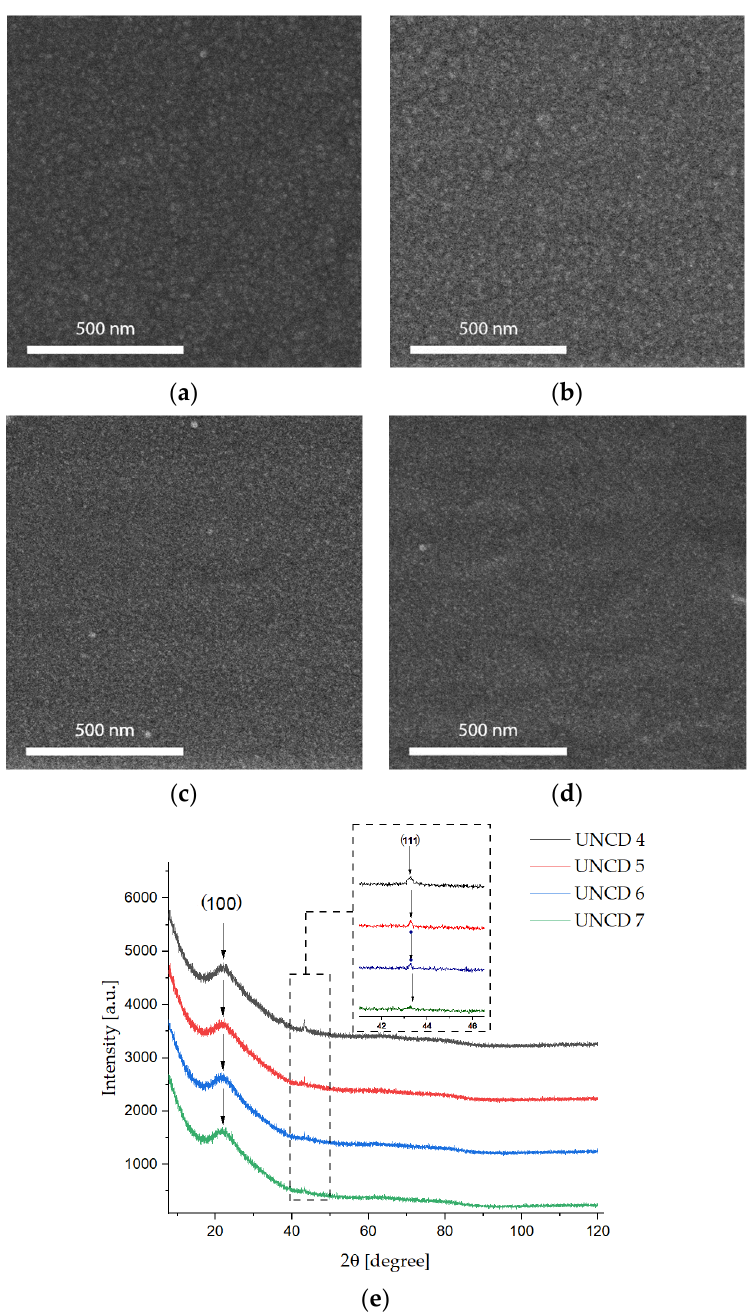
Figure 1. CVD diamond films, with the content of the vapours of methanol in quantities of ( a ) 4% (UNCD-4), ( b ) 5% (UNCD-5), ( c ) 6% (UNCD-6), and ( d ) 7% (UNCD-7), with ( e ) XRD peaks of diamond